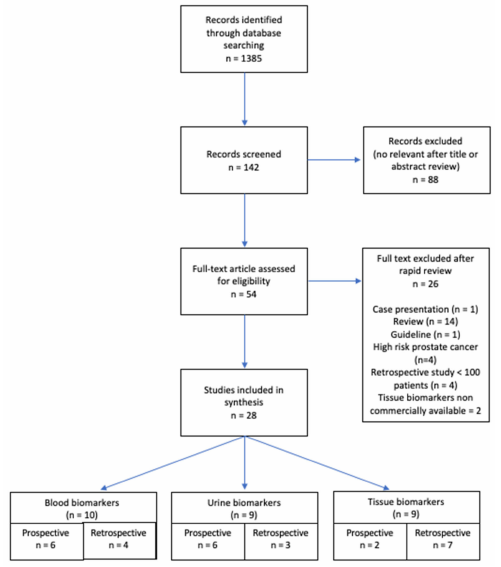
Figure 1. Literature search and selection of studies